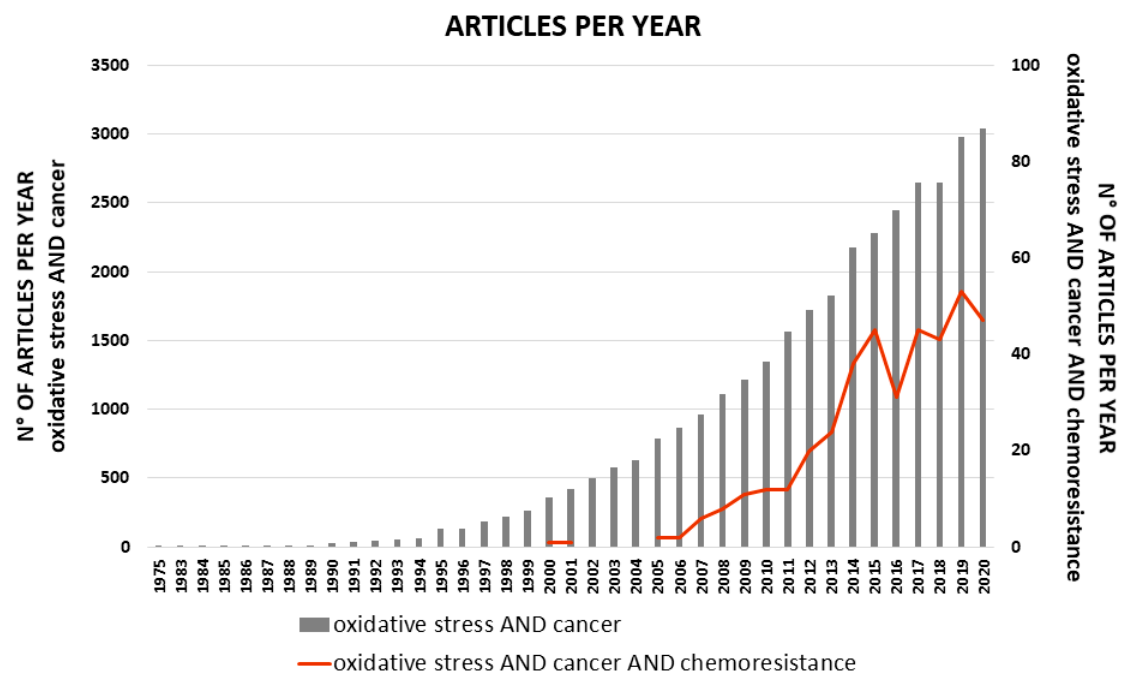
Figure 1. Number of articles per year, reported on PubMed, entering the search filter: “oxidative stress AND cancer” (bar graph; Y -axis on the left side) or “oxidative stress AND cancer AND chemoresistance” (line graph; Y -axis on the right side) in title and/or abstract.